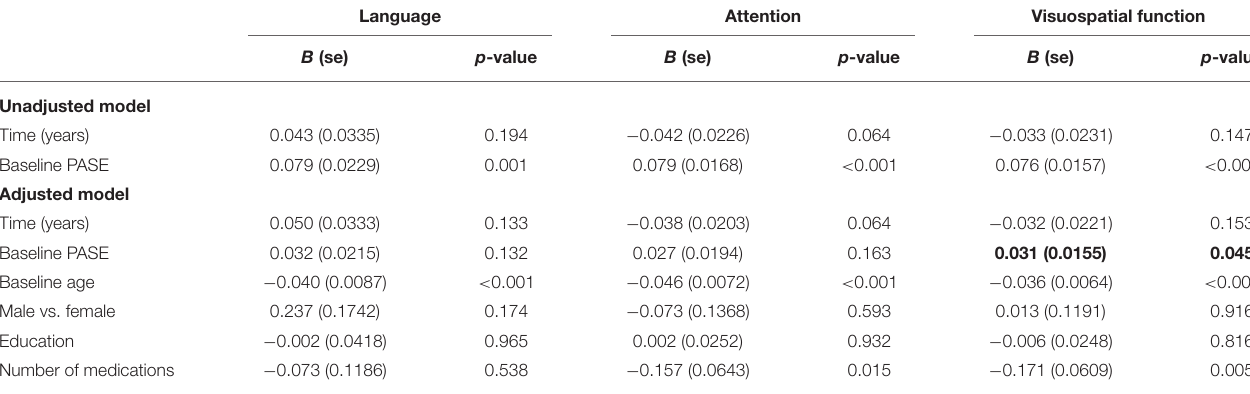
TABLE 4 | Estimated parameters in the linear models without interaction with repeated measures for cognitive change over time. Language Attention Visuospatial function